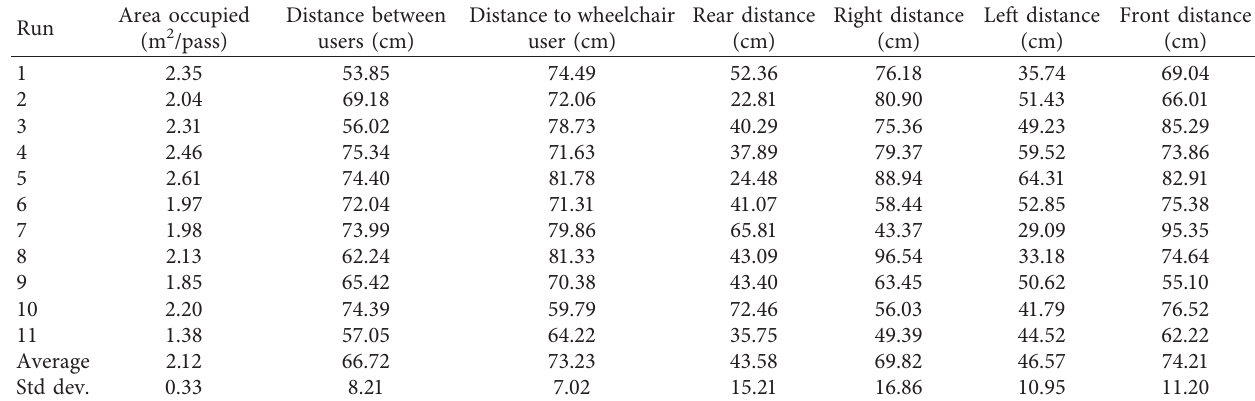
Table 3: Results of the variables for the 1.5 passenger/m 2 scenario in the experiments